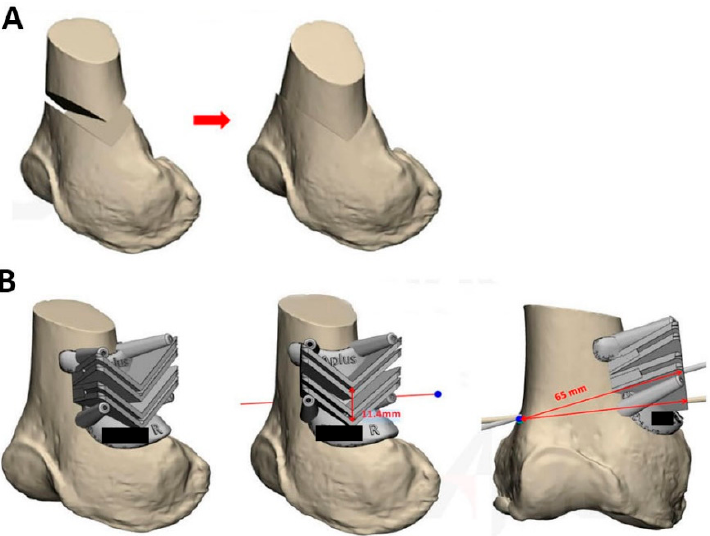
Figure 2. Digital 3D Model Simulation of double chevron-cut DFO. ( A ) The virtual 3D model of the patient in Figure 1. The osteotomy and correction after closing-wedge DFO were simulated. ( B ) A 3D simulation of the 3D-printed cutting jig. The wedge thickness, correction angle, and depth of bone cut were calculated based on the virtual 3D model and printed on the guide as a reminder during the surgery.